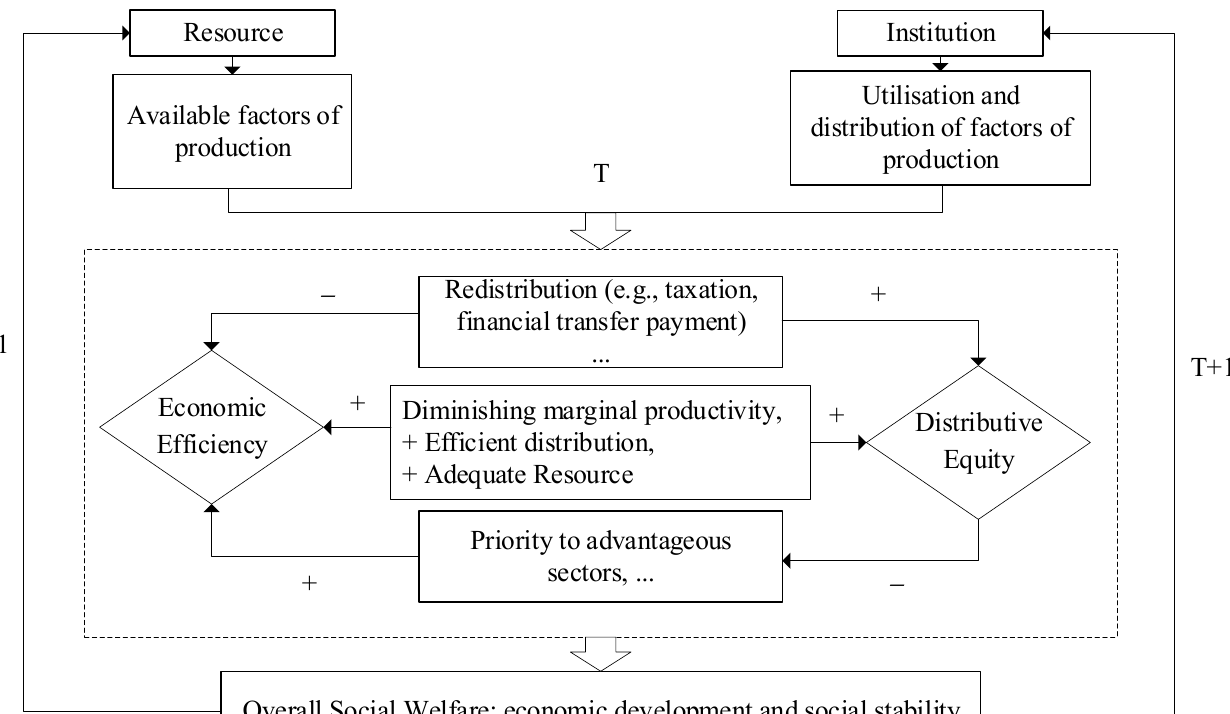
Figure 1. Theoretical analysis framework of institutional changes, based on economic efficiency and distributive equity.